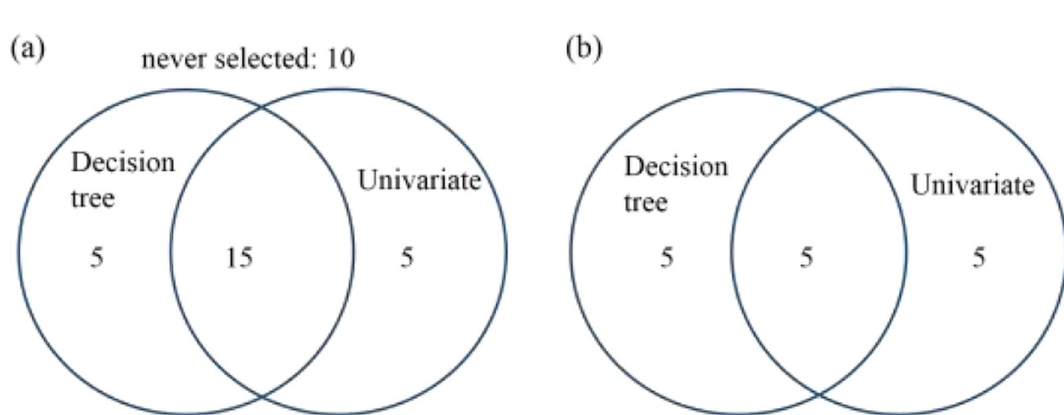
Figure 3. R 2 ( a ) and RMSE ( b ) of test data (holdout set) predicted by models built by different descriptors subsets under shuffled cross-validation.